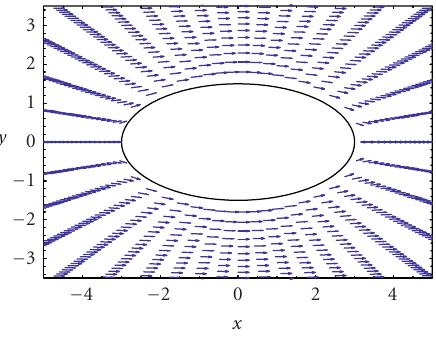
Figure 3.1. Velocity field of an irrotational, inviscid flow around an ellipsoid with semiaxes a = 3, b = 1 . 5, c = 0 . 75, and a Reynolds number of 0 . 05. Two-dimensional representation of the velocity field at the centerline of the ellipsoid ( z =